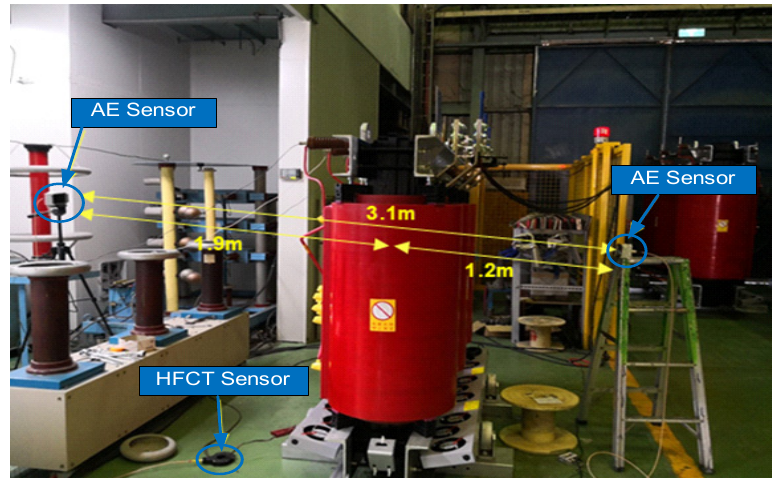
Figure 12. installation of AE sensor and HFCT sensor without housing of transformer. Figure 12. Installation of AE sensor and HFCT sensor without housing of